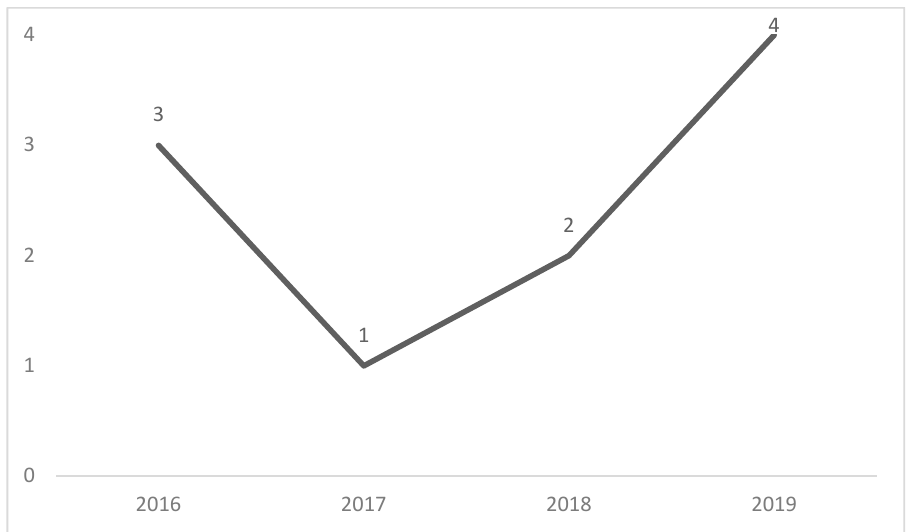
Figure 2 . Number of articles per year . Figure 2. Number of articles per year.